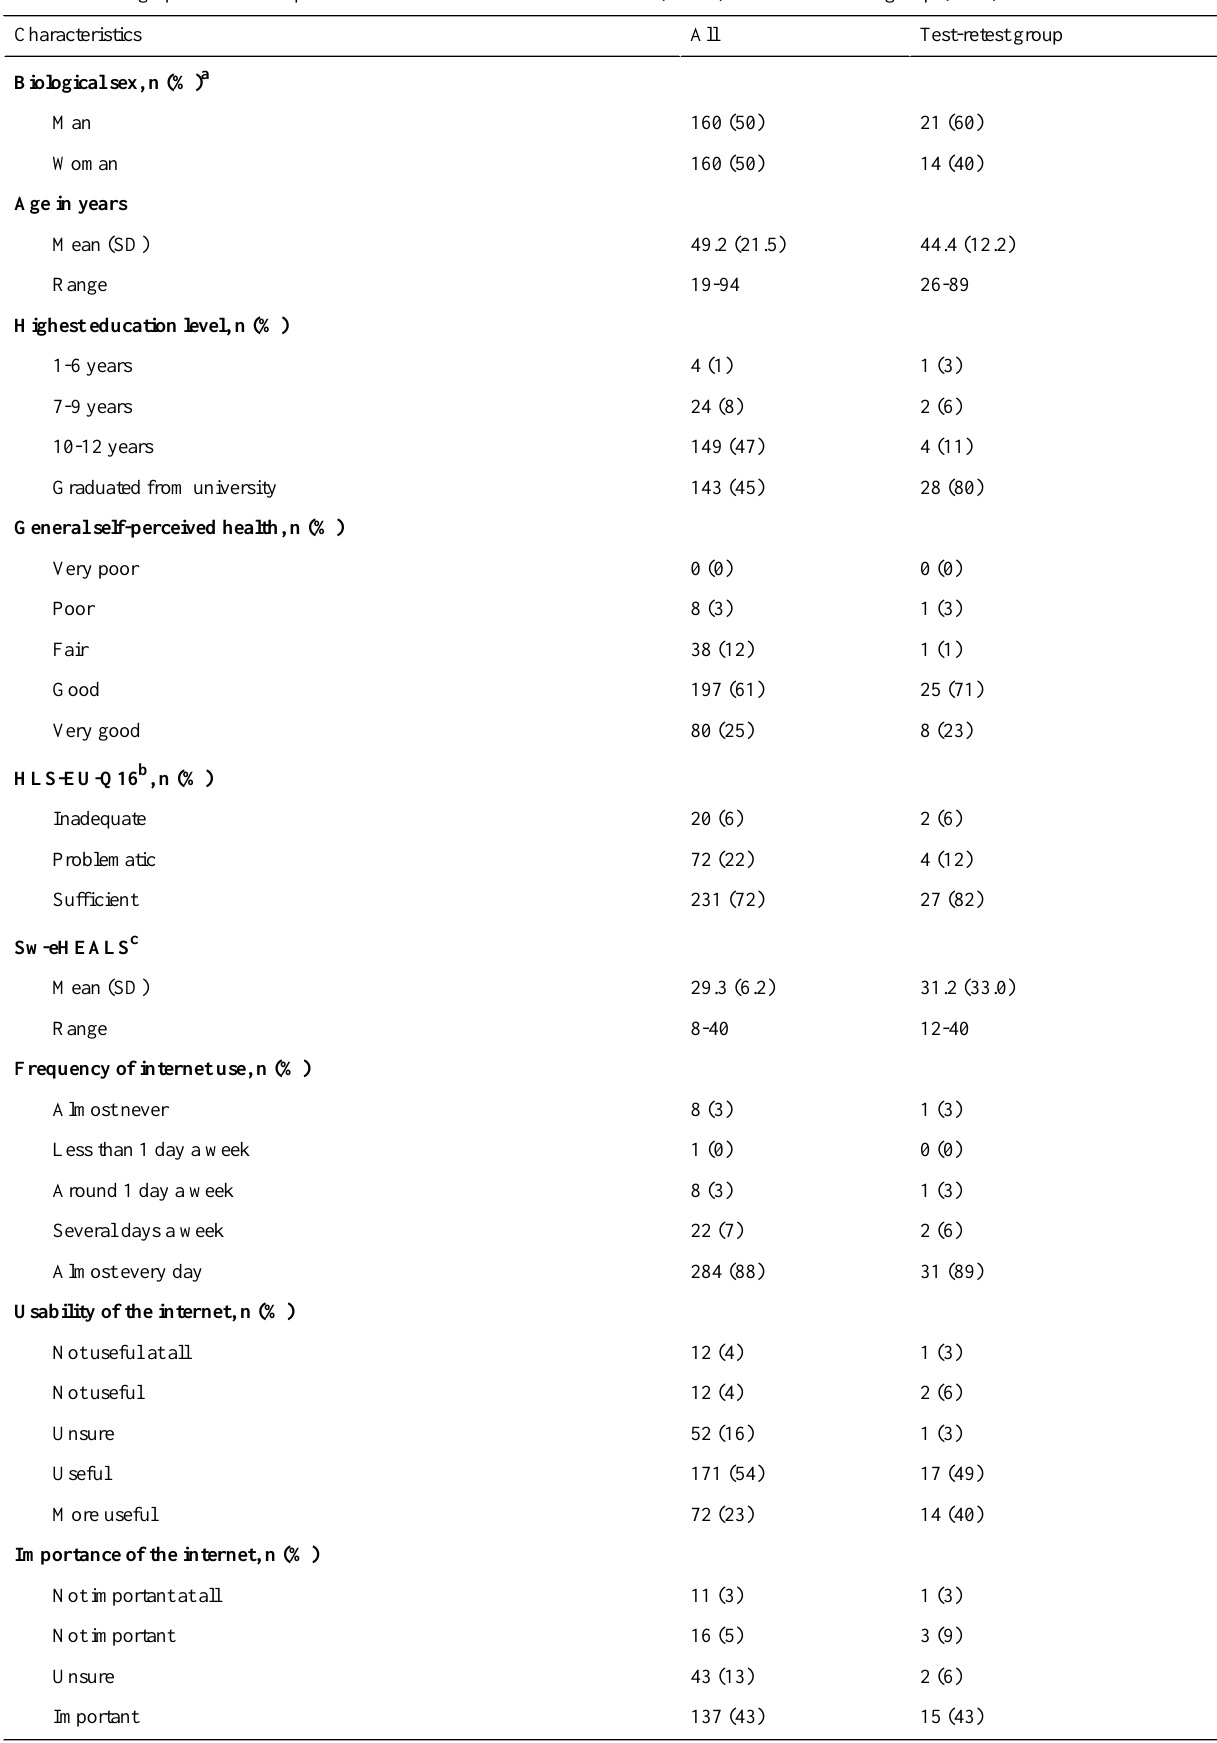
Table 2. Demographics of the respondents with a valid eHEALS sum score (n=323) and the test-retest group (n=35).